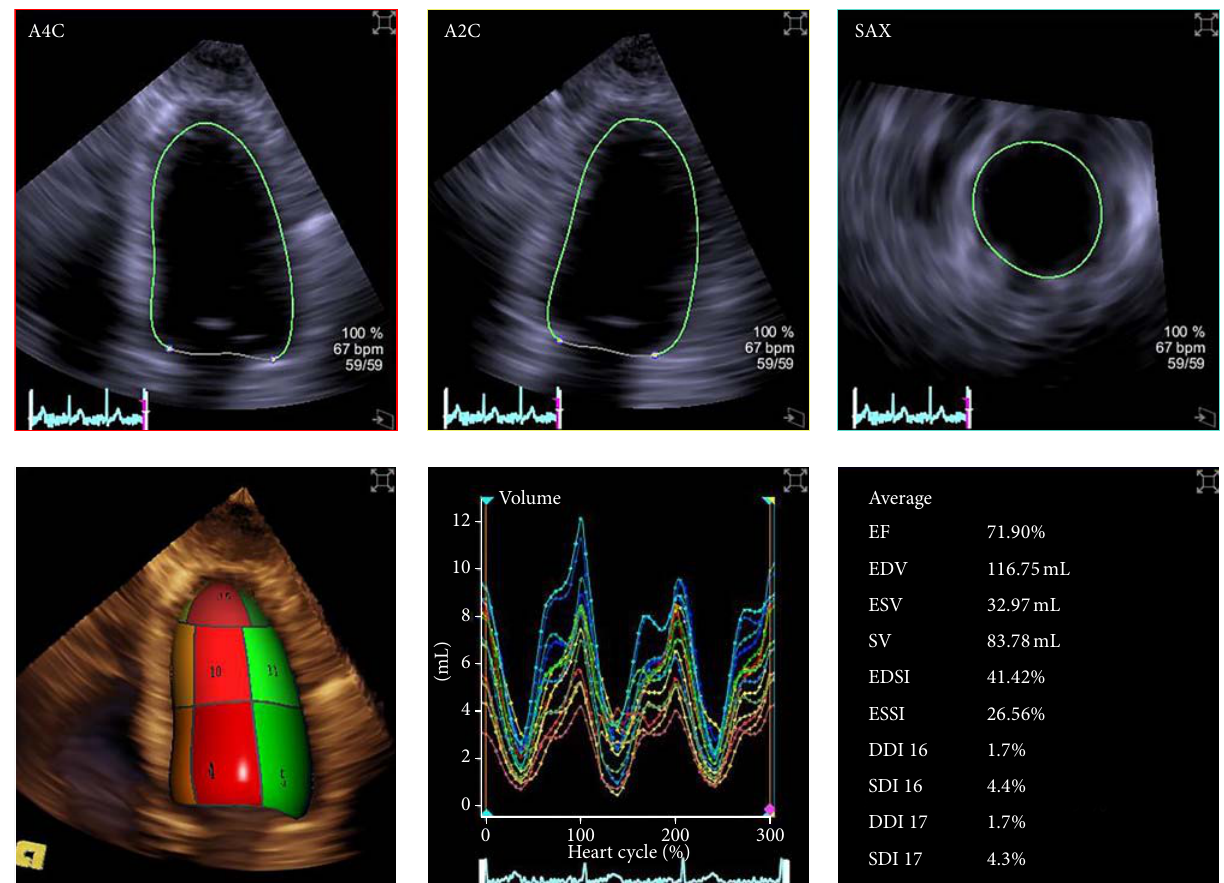
Figure 11: Single-beat full-volume acquisition and automatic endocardial border detection allow fast assessment of left ventricular volume and ejection fraction with the possibility of averaging results over multiple cardiac